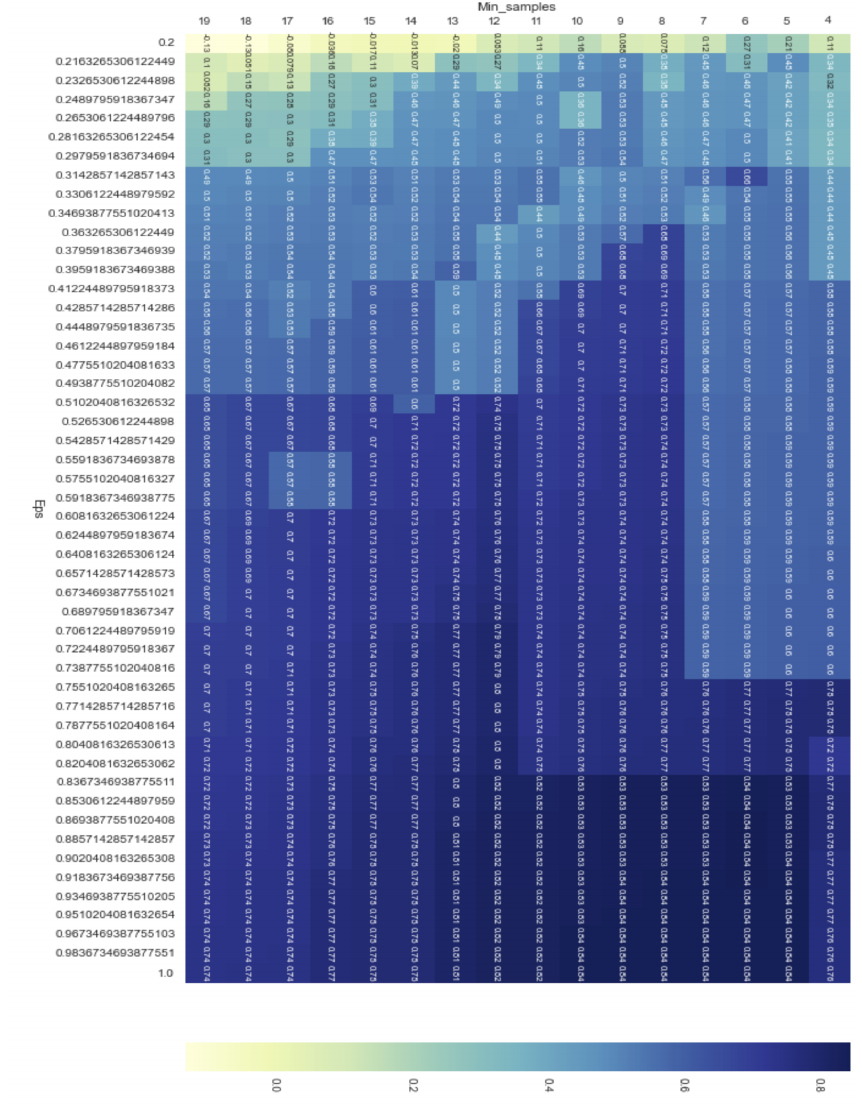
Figure 18. Heatmap displaying the result of DBSCAN clustering based on a different combination of Eps and MinPts for 3-dimensional input data: Latitude , Longitude , SOG